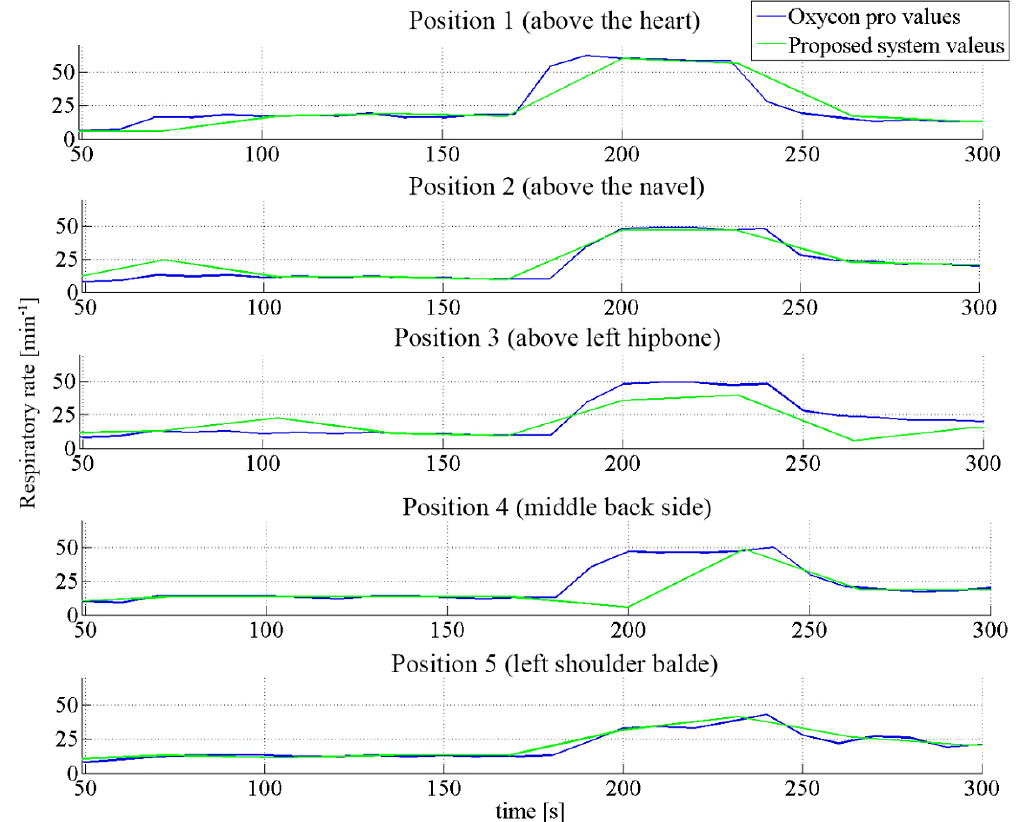
Figure 9. Cross comparison of respiratory data sets from our sensing system and from commercial